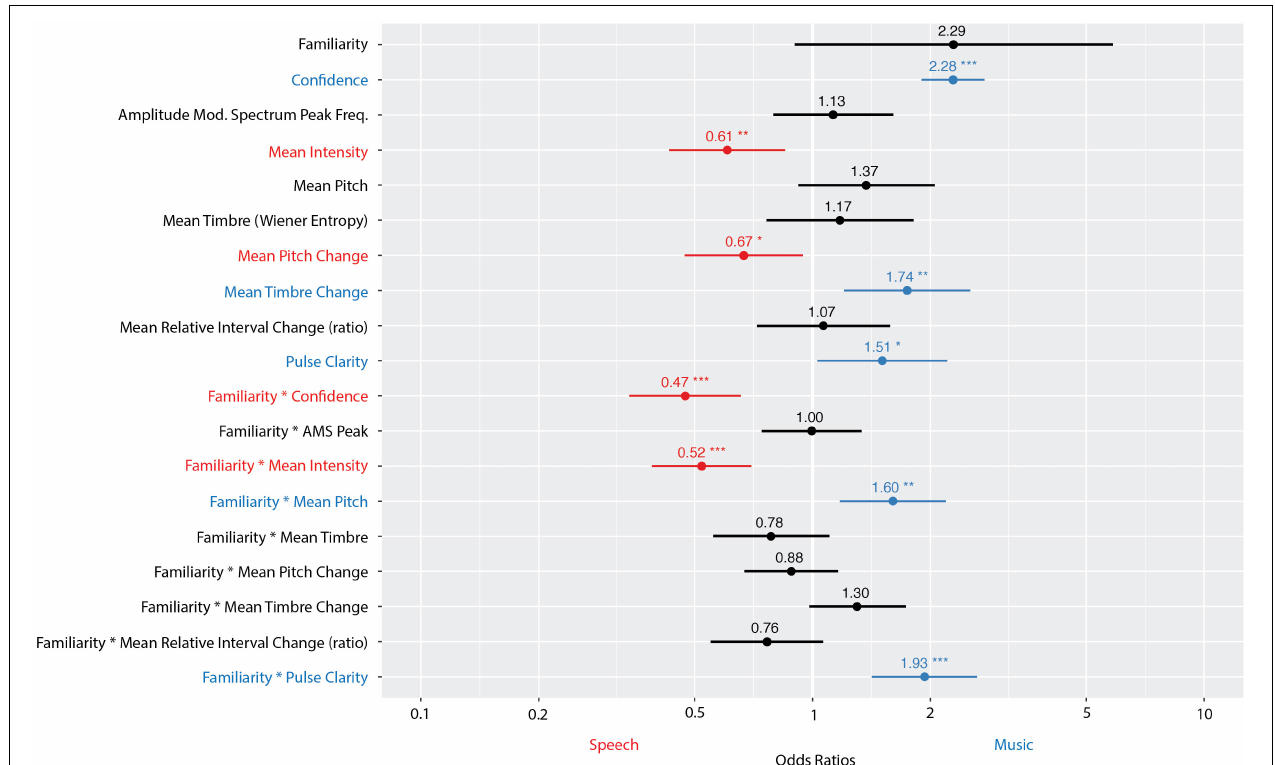
FIGURE 6 | Odds ratios, with confidence interval (CI), for each fixed effect in a logistic regression model predicting participants’ perception of stimuli as music-like (1) or speech-like (0). The vertical line at 1 indicates no effect (i.e., any fixed effect predictor whose odds ratio CI overlaps 1 does not significantly predict participants’ perception). Fixed effects with an odds ratio < 1 (red) indicate that a high value on that feature leads to the perception of speech. Odds ratios > 1 (blue) indicate that a high value on that feature leads to the perception of music. The significance of each fixed effect is indicated with stars (*** p < 0.001, ** p < 0.01, and * p < 0.05). Number of observations: 3,210. Familiarity was a binary predictor (0 = no; 1 = yes); confidence ranged from 0 to 3; all other variables were